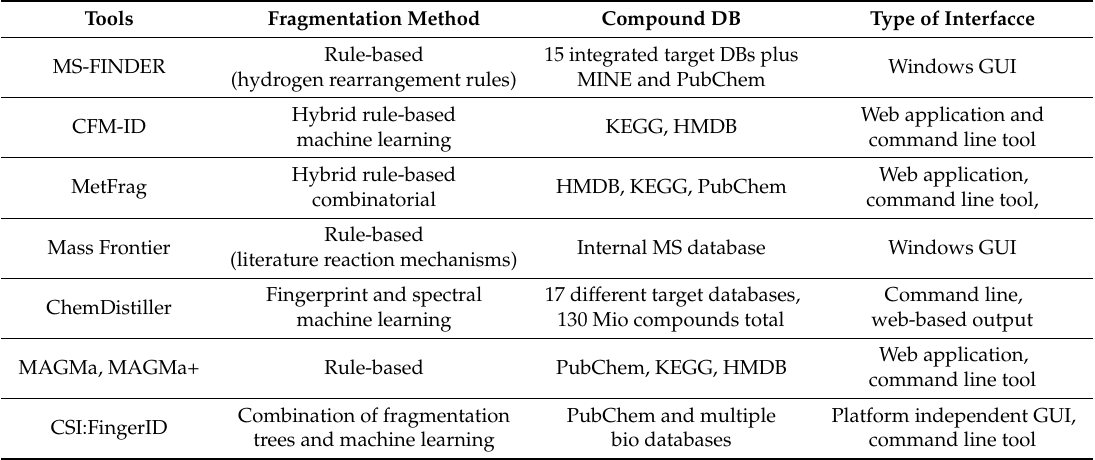
Table 5. Selection of in silico fragmentation software, including commercially or freely available algorithms. Additional algorithms are referenced in the